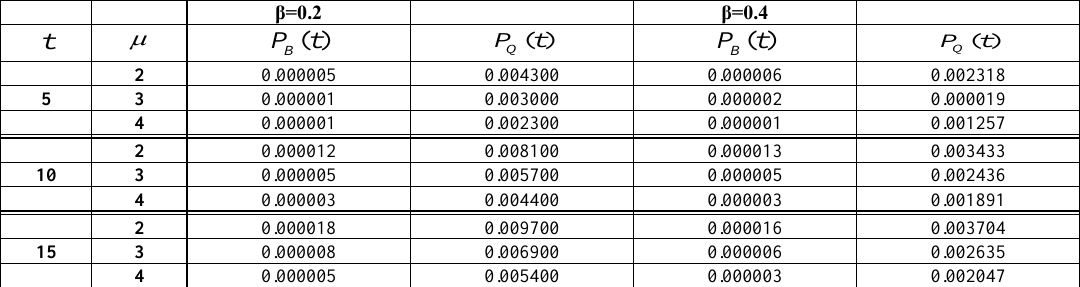
Table 2. Effect of β on state probabilities